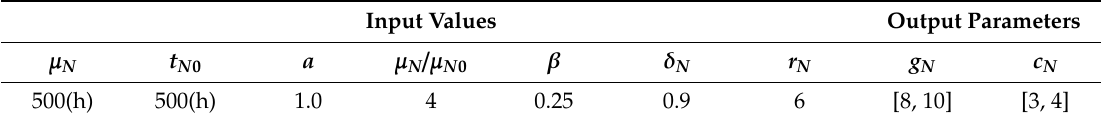
Table 5. Summary of input values and output parameters.